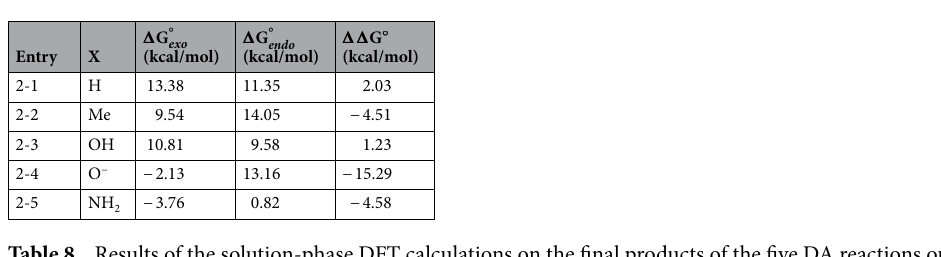
Table 8. Results of the solution-phase DFT calculations on the final products of the five DA reactions outlined in Fig. 4.